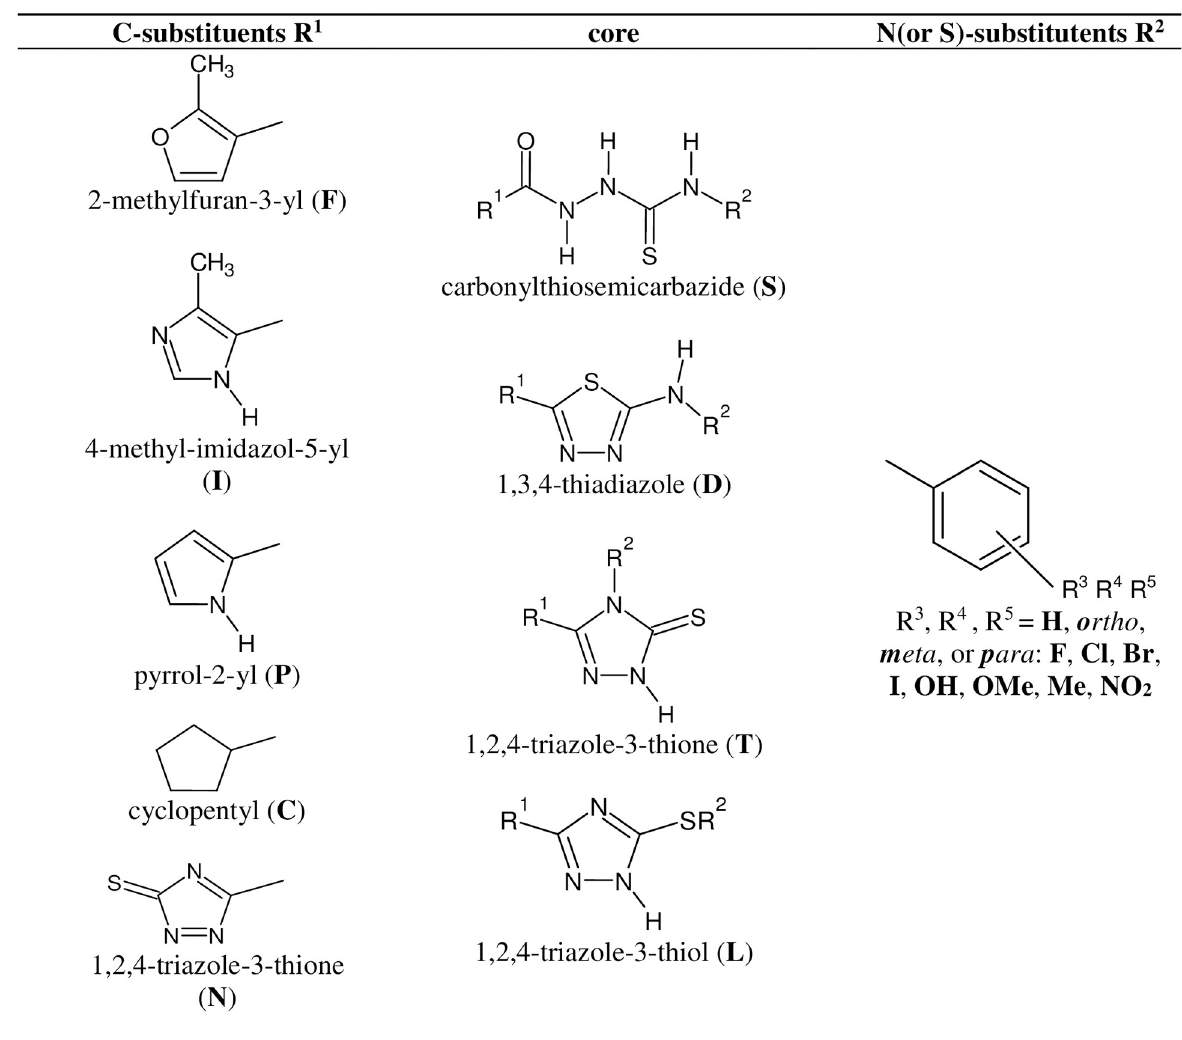
Fig 4. Components of structural fragments of compounds used in current studies.